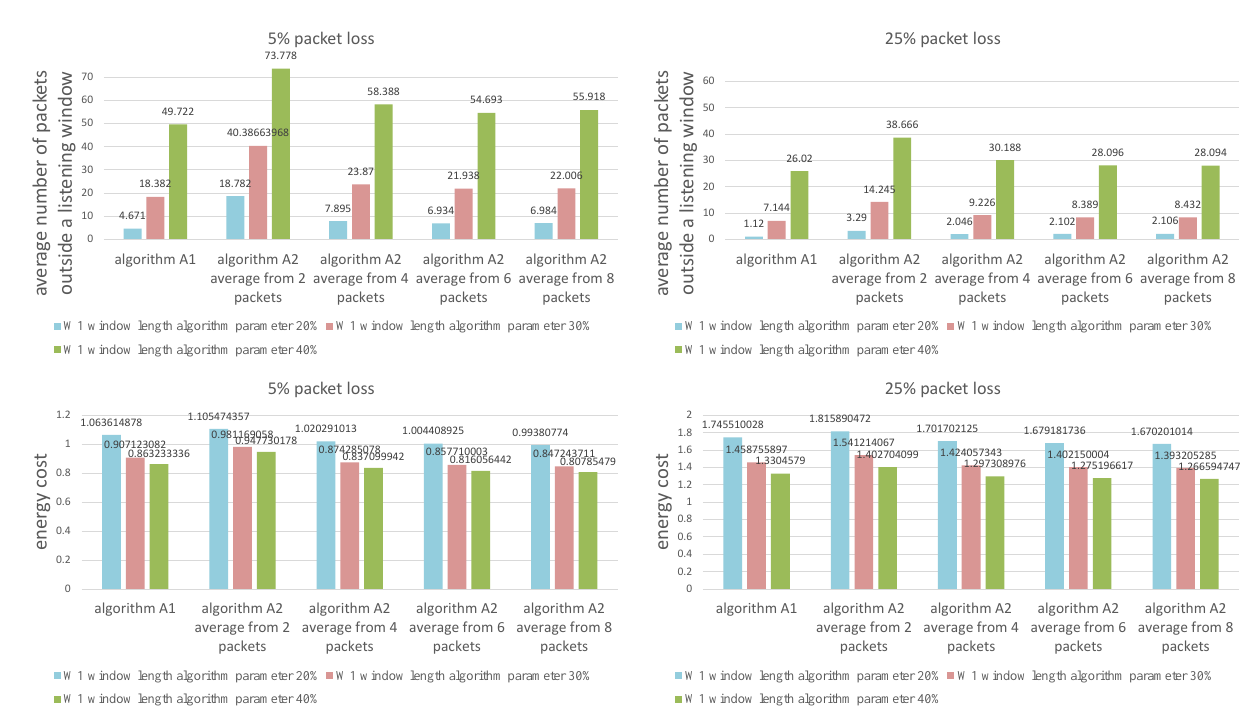
Figure 4. Comparison of window length change